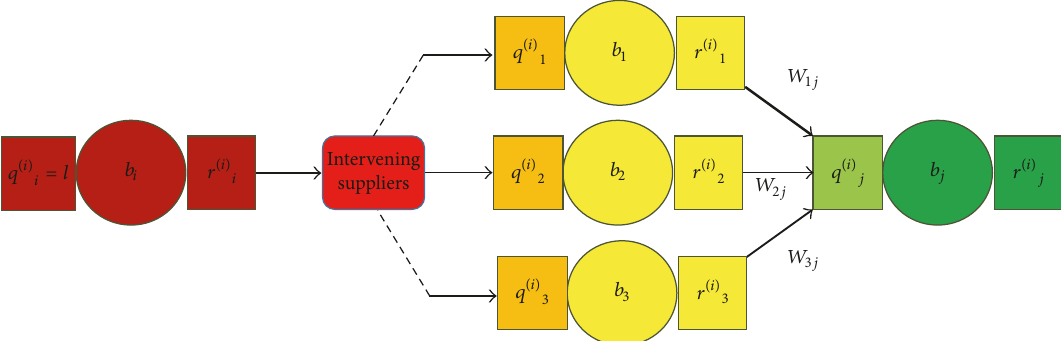
Figure 1: Schematic representation of a supply chain network as a directed, acyclic graph. Node 𝑖 represents where an initial loss 𝑙 originates. The loss may propagate downstream through intervening nodes (omitted) to node 𝑗 . Also shown are three nodes representing immediate suppliers of 𝑗